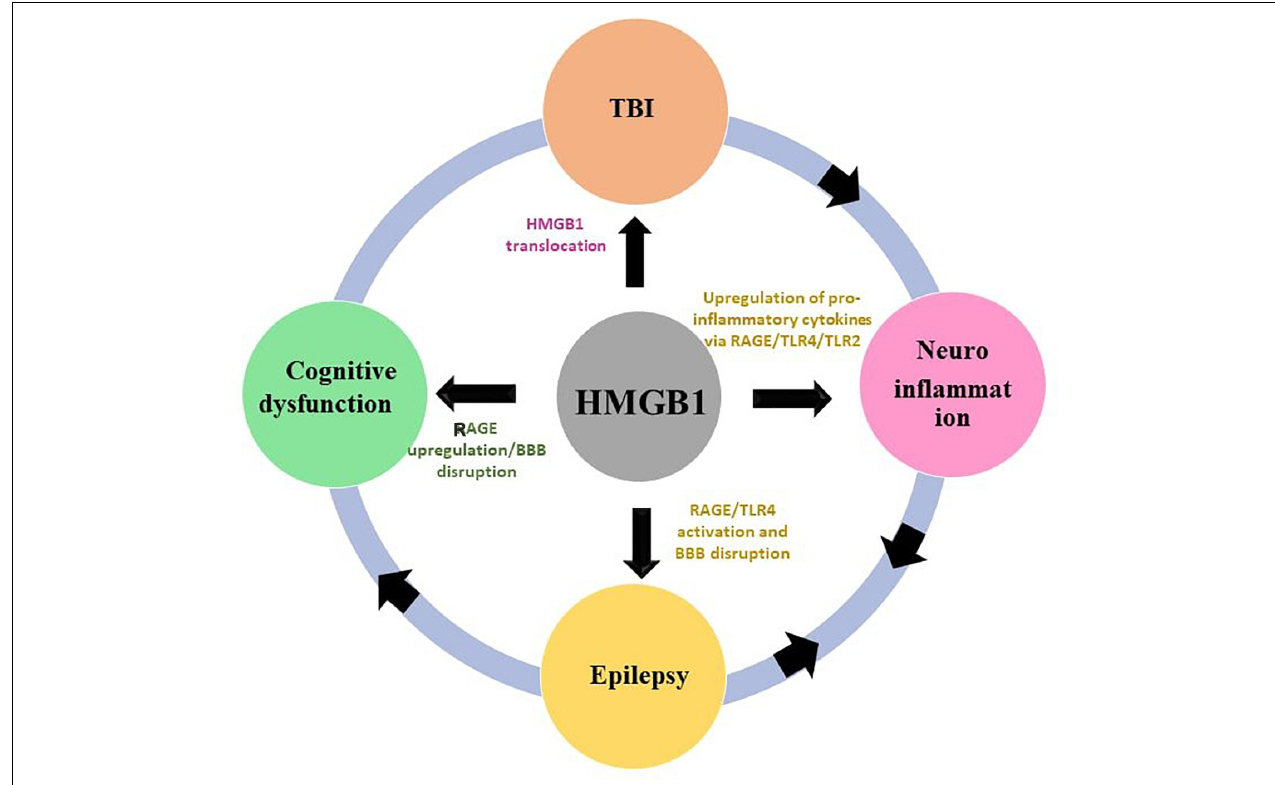
FIGURE 1 | Interlinkage of HMGB1 with TBI, neuroinflammation, epilepsy and cognitive dysfunction. The HMGB1 contributes to the pathogenesis of TBI, neuroinflammation, epilepsy, and cognitive dysfunction through a putative mechanism outlined in this figure.